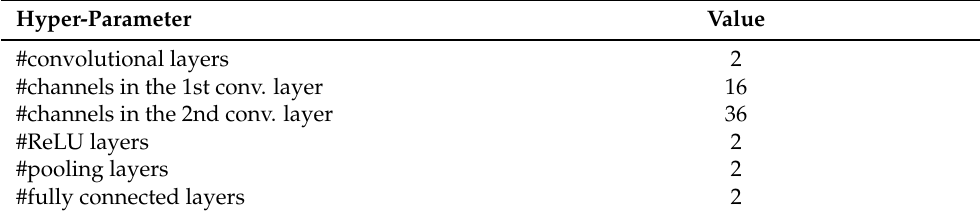
Table 1. Fixed Hyper-Parameters Defining the Topology of the CNNs for MNIST. Hyper-Parameter Value #convolutional layers 2 #channels in the 1st conv. layer 16 #channels in the 2nd conv. layer 36 #ReLU layers 2 #pooling layers 2 #fully connected layers